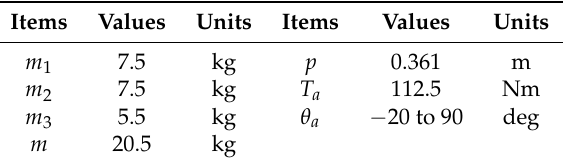
Figure 27. The experiment of the shoulder joint. ( a ) The load illustration of the shoulder joint. ( b ) The experiment of the shoulder joint on a table [9]. Table 1. General parameters of the manipulator. m 1 represents the mass of the shoulder joint; m 2 represents the mass of the wrist joint; m 3 represents the mass of the scissors joint; m represents the mass of the manipulator; p represents the location of the mass center; T a represents the maximum torque that the shoulder joint can bear; θ a represents the motion range of the shoulder joint.